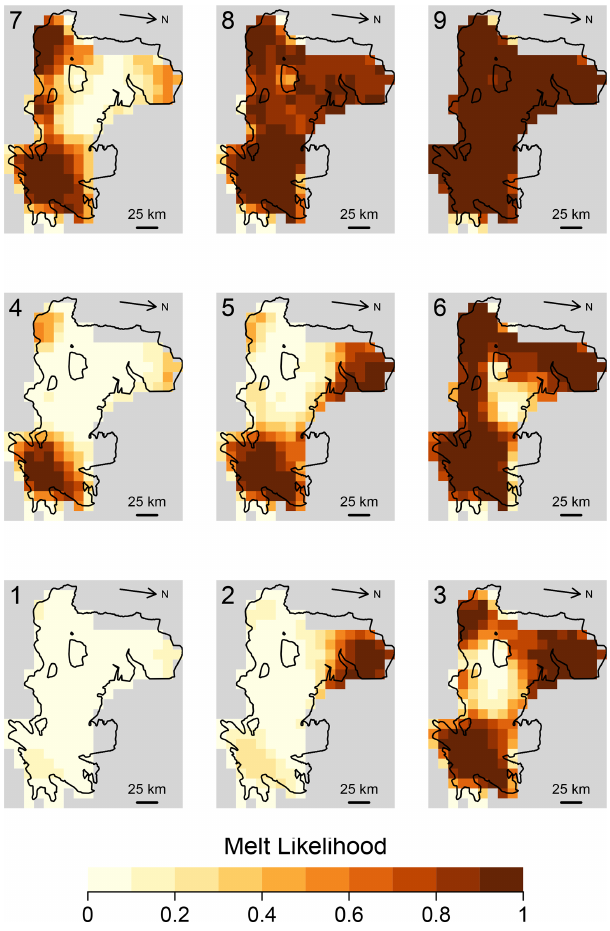
Figure 2. Result of the self-organising map, showing that nine rep- resentative melt patterns can describe the spatial variability in sur- face melt on the Shackleton Ice Shelf (2002/03–2020/21). Pixel val- ues indicate how likely melt will be observed in a pixel on the days best described by the respective pattern; further explanation can be found in Sects. 3.2 and